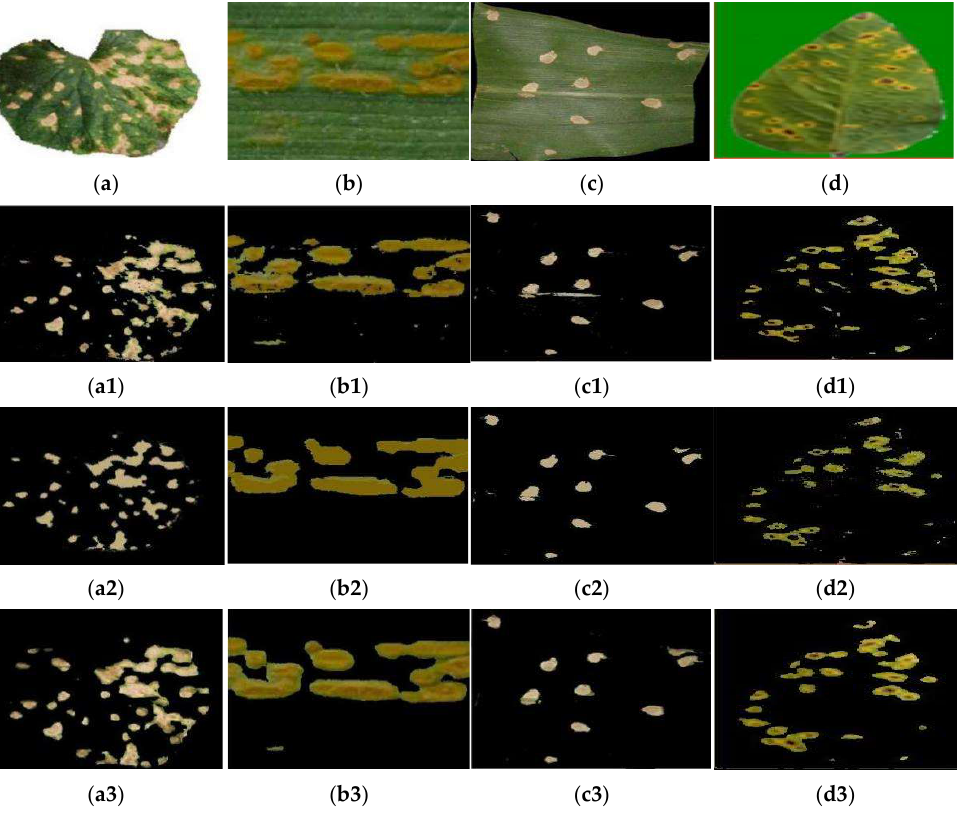
Figure 5. Lesion segmentation results based on different algorithms. ( a ) Diseased leaf image. ( b ) Diseased leaf image. ( c ) Diseased leaf image. ( d ) Diseased leaf image. ( a1 ) Segmentation results with the K-means method. ( b1 ) Segmentation results with the K-means method. ( c1 ) Segmentation results with the K-means method. ( d1 ) Segmentation results with the K-means method. ( a2 ) Segmentation results with the mean shift method. ( b2 ) Segmentation results with the mean shift method. ( c2 ) Segmentation results with the mean shift method. ( d2 ) Segmentation results with the mean shift method. ( a3 ) Segmentation results using our method. ( b3 ) Segmentation results using our method. ( c3 ) Segmentation results using our method. ( d3 ) Segmentation results using our method.